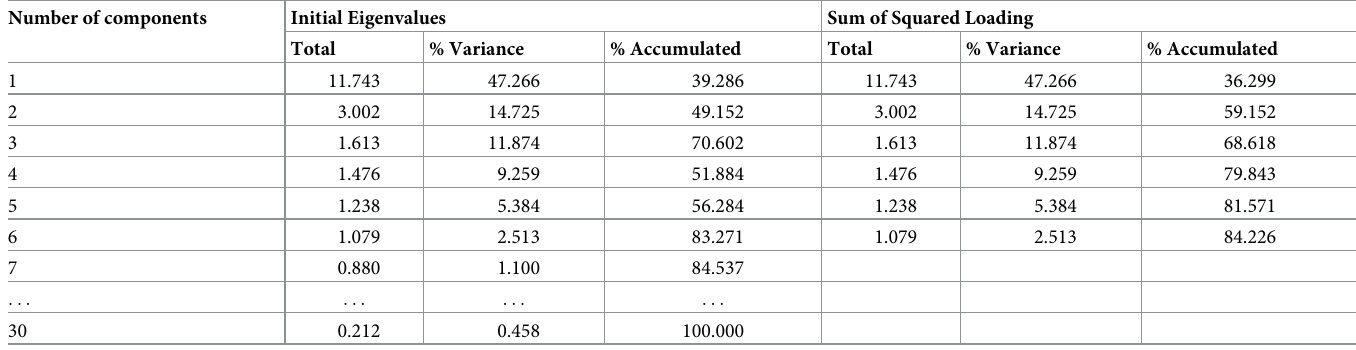
Table 7. Total variance explained by the